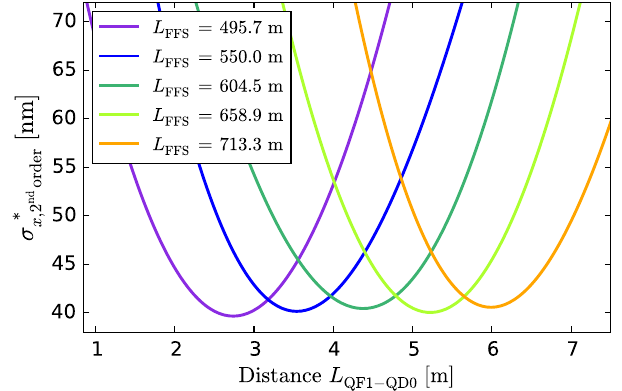
optimization, as a function QF 1 -QD 0